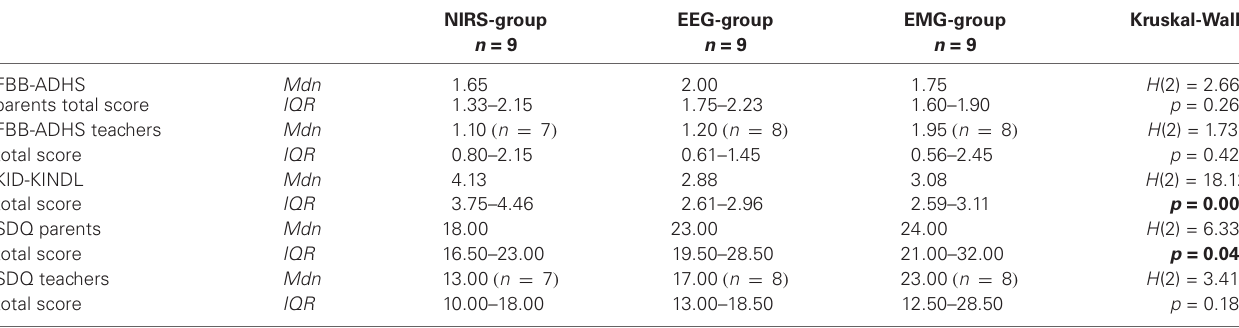
Table 4 | Medians and interquartile ranges of FBB-ADHS, KID-KINDL and SDQ at pretest with group statistics .